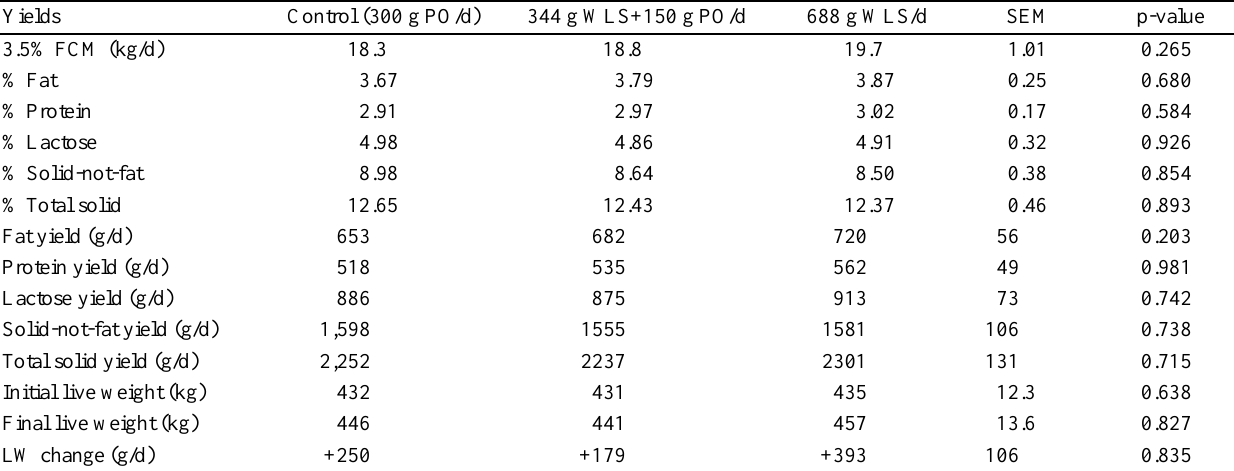
Table 4. Effects of whole linseed supplementation on milk yield, milk composition, final liveweight and live weight change